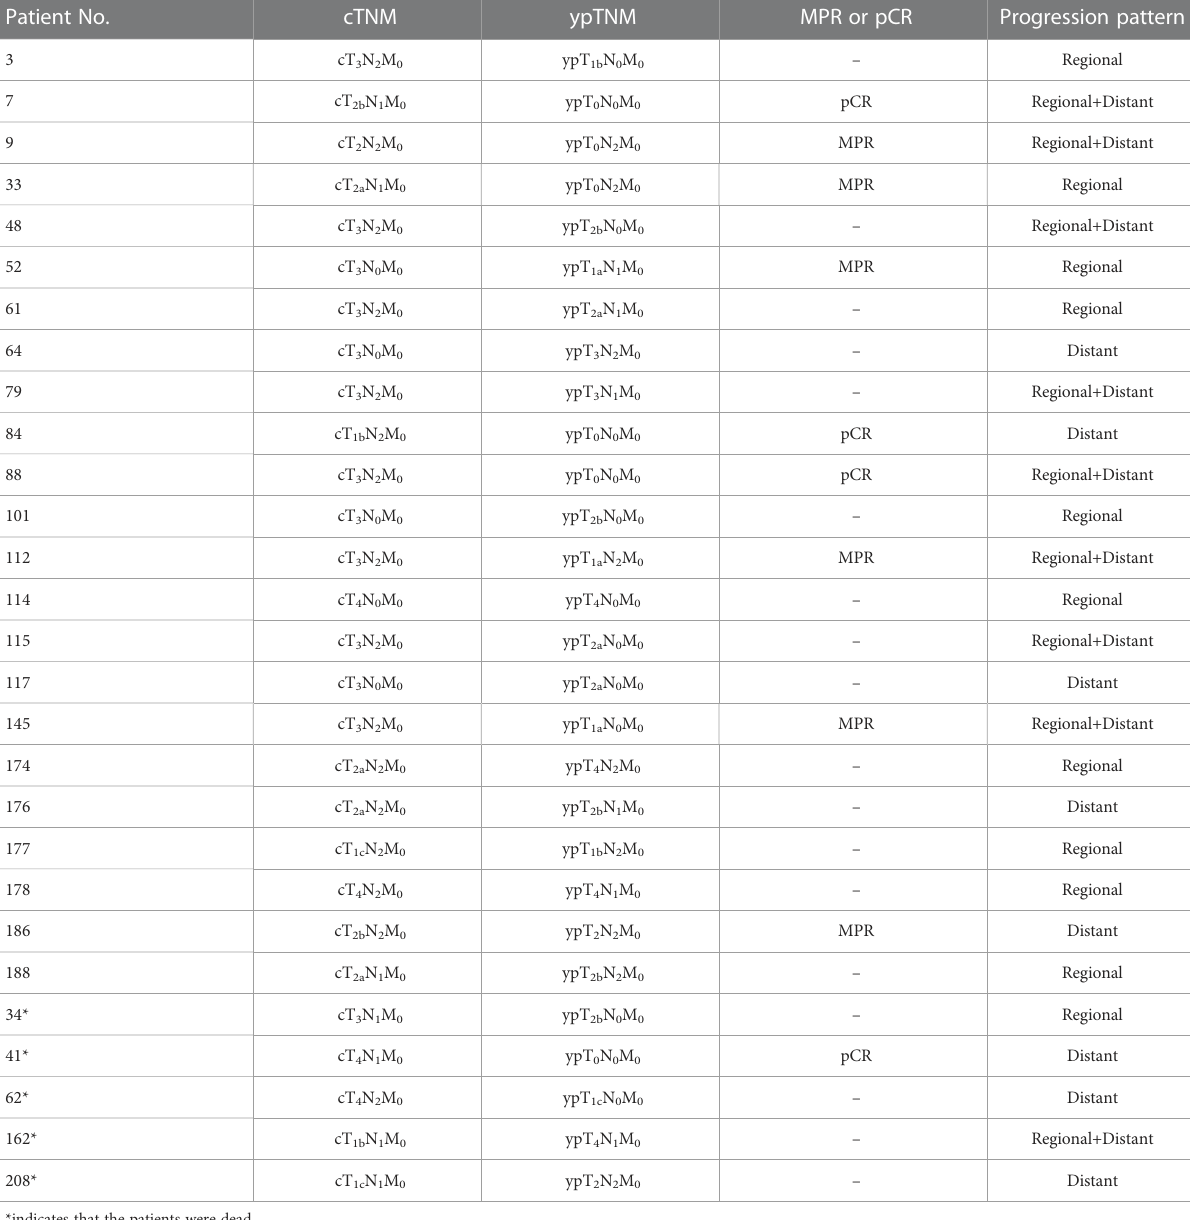
TABLE 2 The speci fi c progression patterns of 28 patients. Patient